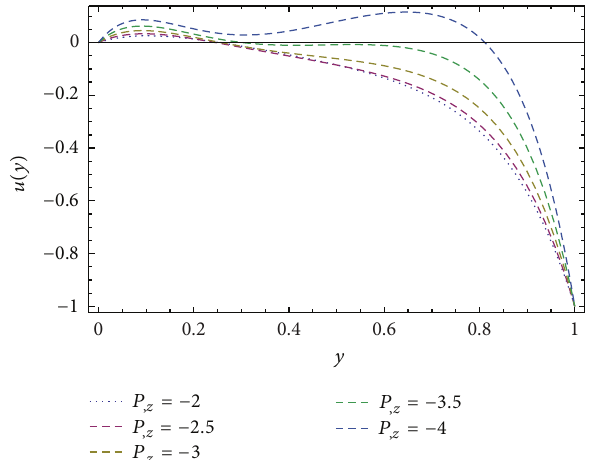
Figure 7: Profile of the nondimensional velocity 𝑤(𝑦) for different ̃ 𝛽 = 0.3 , 𝑃 ,𝑧 = −2.0 , and 𝜙 = 45 ∘ . values of 𝑃 ,𝑥 , keeping